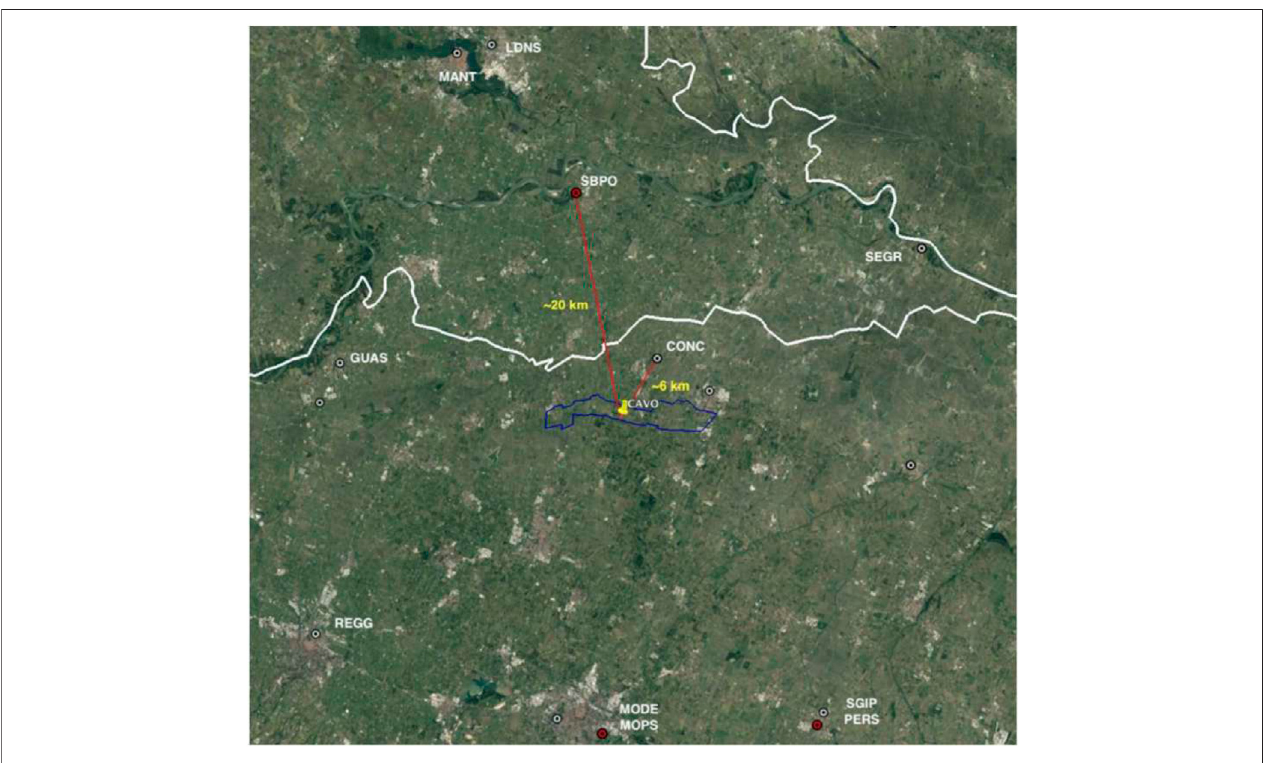
FIGURE 7 | Location of the Cavone GNSS station (CAVO) and distance from the nearest active GNSS stations, with the OWC extension projected on the surface shown in blue. Red circles: active RING stations, white circles with names: other active GNSS stations; white circles with no names: other inactive GNSS stations.